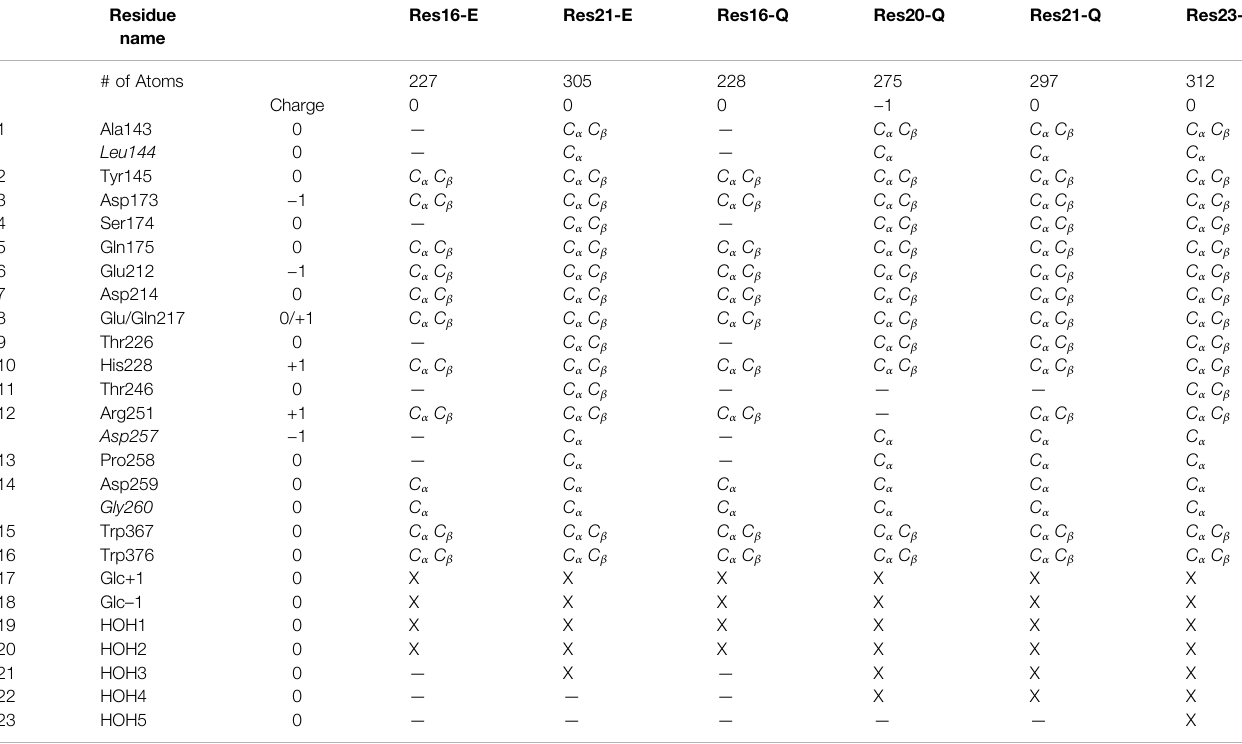
TABLE 1 | Residue and trimming information for the various QM-cluster models built in this study. Residue name